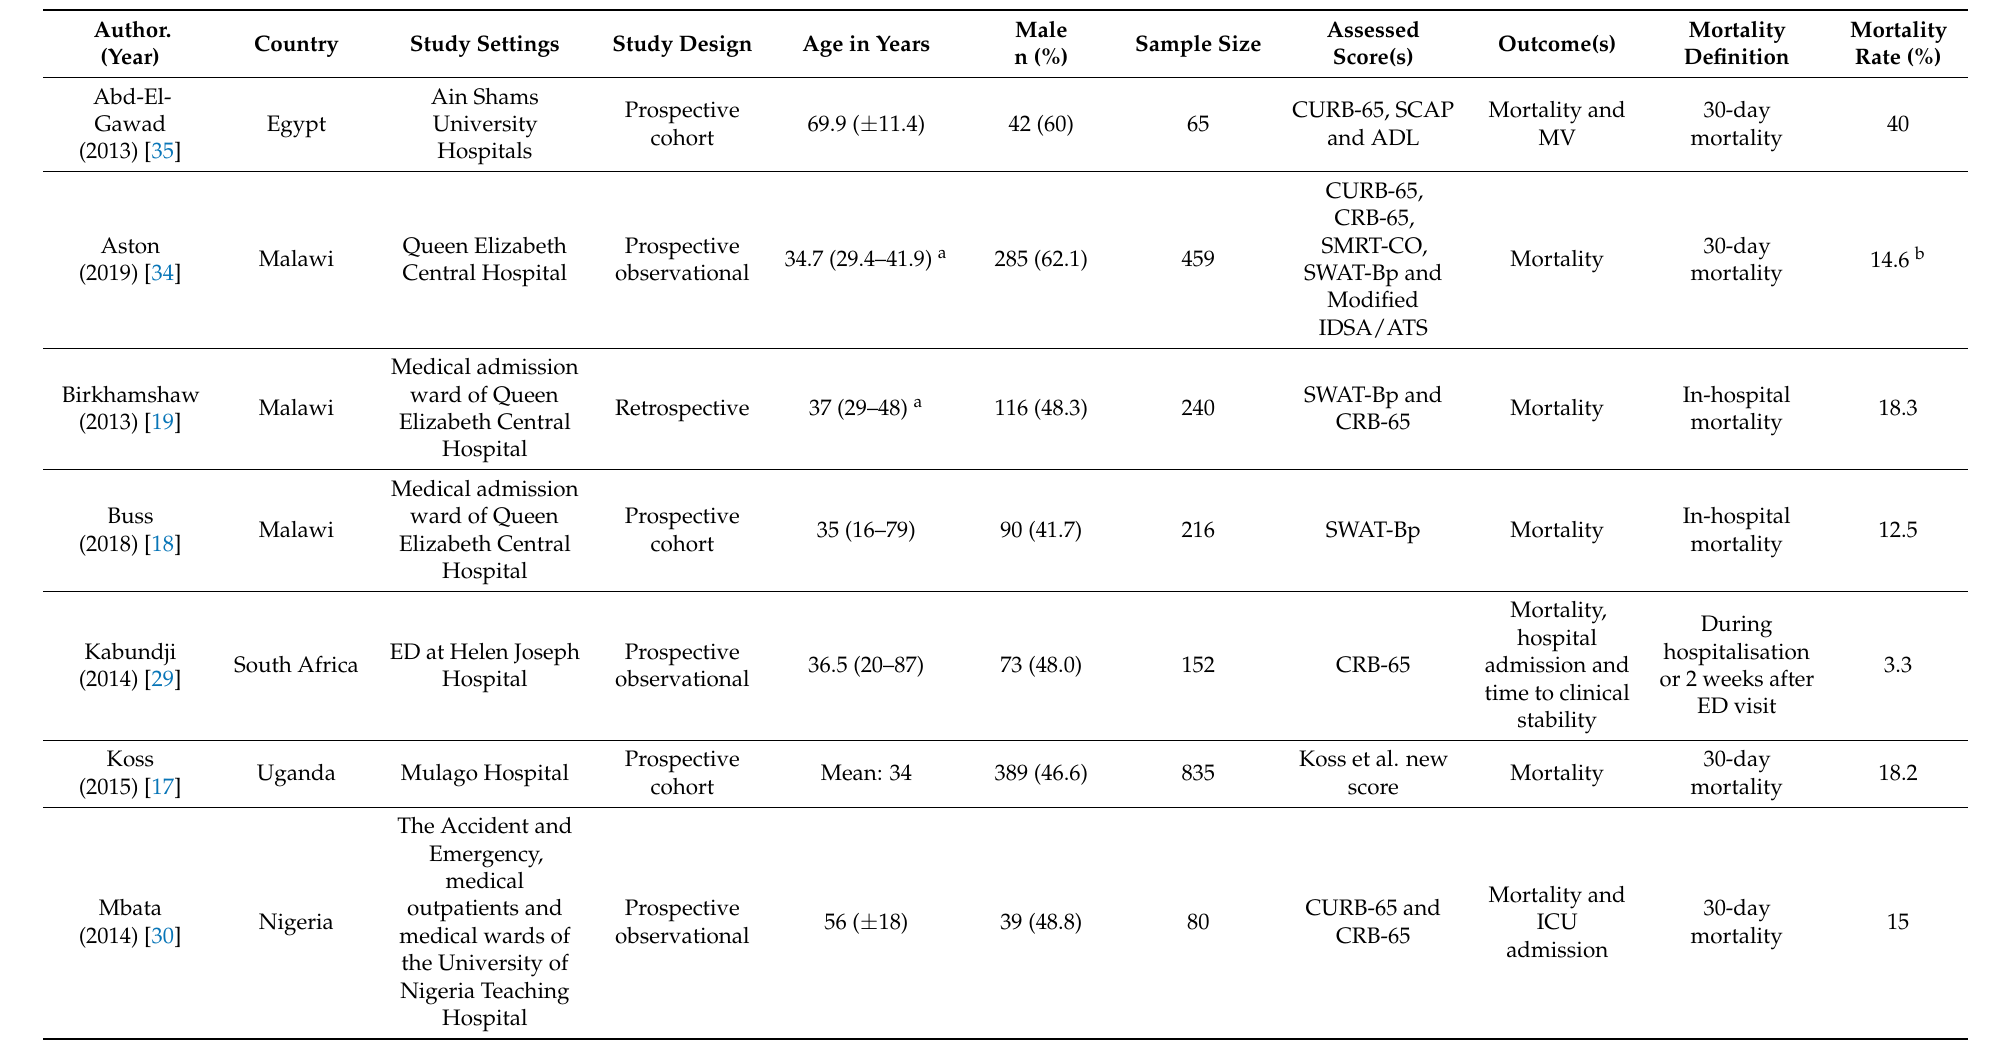
Table 1. Characteristics of the included